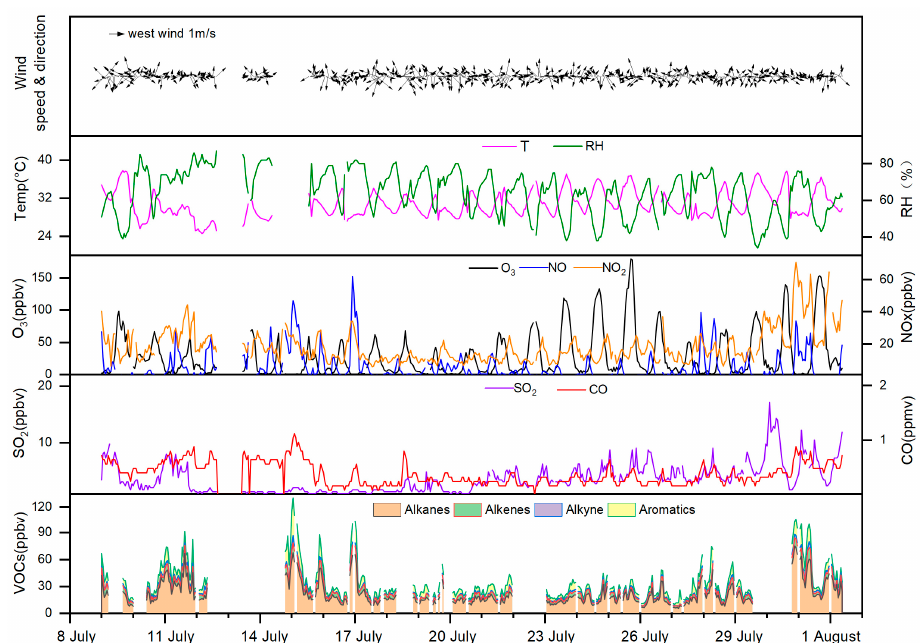
Figure 3. Time series of wind speed and direction, temperature (Temp) and relative humidity (RH), O 3 , NO, NO 2 , SO 2 , CO and VOCs concentrations at the MDS site.